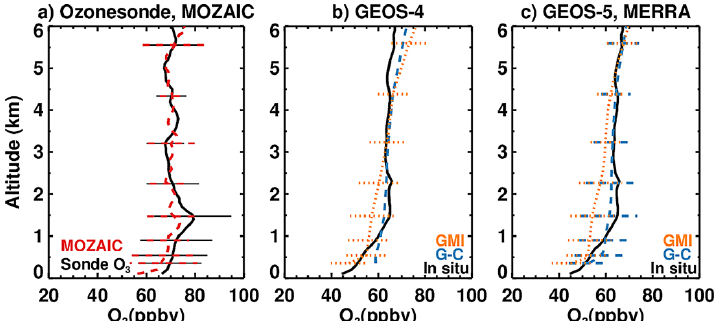
Figure 4. (a) Mean vertical profiles of O 3 mixing ratios (ppbv) over Beijing averaged over 4 days (1, 3, 11, and 15 May), when both ozonesonde (black solid line) and MOZAIC aircraft (red dashed line) measurements were conducted. (b) Mean vertical profiles of O 3 mixing ratios observed by ozonesonde and MOZAIC aircraft during April–May 2005 (solid black line), compared to GEOS-Chem (blue dashed line) and GMI (orange dotted line) simulations driven by the GEOS-4 meteorological fields. Daily model output was sampled at the time and location of ozonesonde and aircraft measurements. (c) Same as (b) , except that GEOS-Chem and GMI were driven by the GEOS-5 and MERRA meteorological fields,